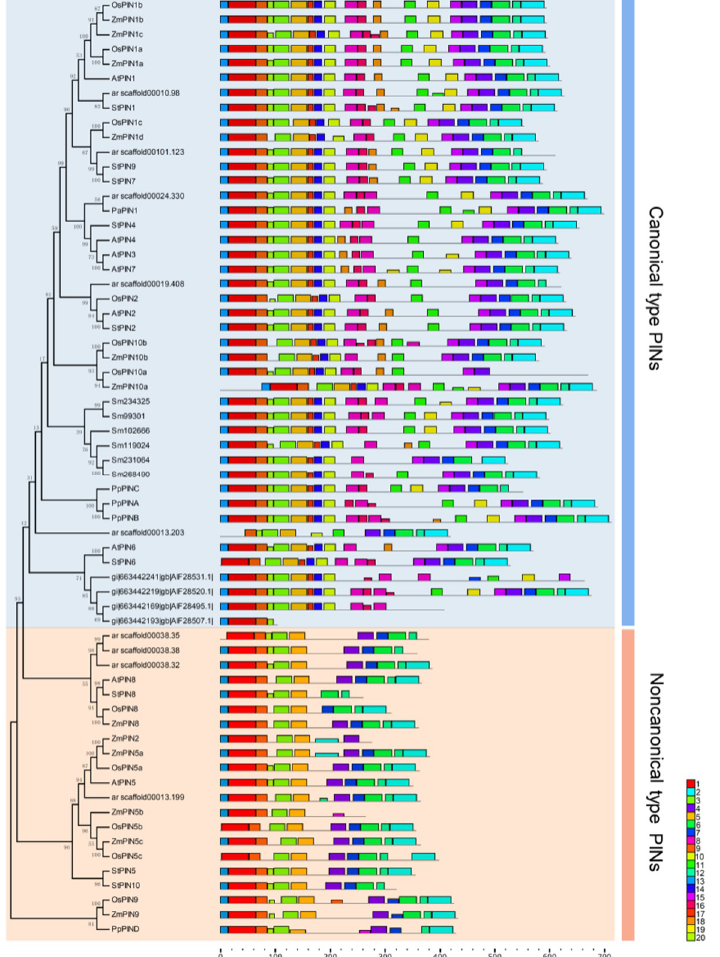
Figure 2. Motif compositions of the PIN genes in ten representative plant species. Phylogenetic tree of 66 PIN proteins from different lineages, including K. flaccidium (algae), P. patens (moss), S. moellendorffii (lycophytes), C. fragilis (ferns), P. abies (gymnosperm), A. trichopoda (amborellales), A. thaliana and S. tuberosum (dicots) and O. sativa and Z. mays (monocots). The unrooted Neighbor- joining phylogenetic tree was constructed with MEGA7 software. Predicted motifs of the PIN proteins were displayed by the MEME web server (Available online: http://meme.sdsc.edu) under the parameters set as default values, expect for the maximum number of motifs is 20. Twenty predicted motifs were shown by different colored boxes, and motif sizes were demonstrated by the scale on the right.